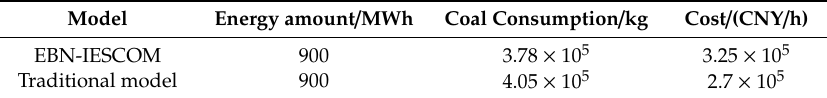
Table 11. Simulation results of energy consumption and cost in ESCO9.